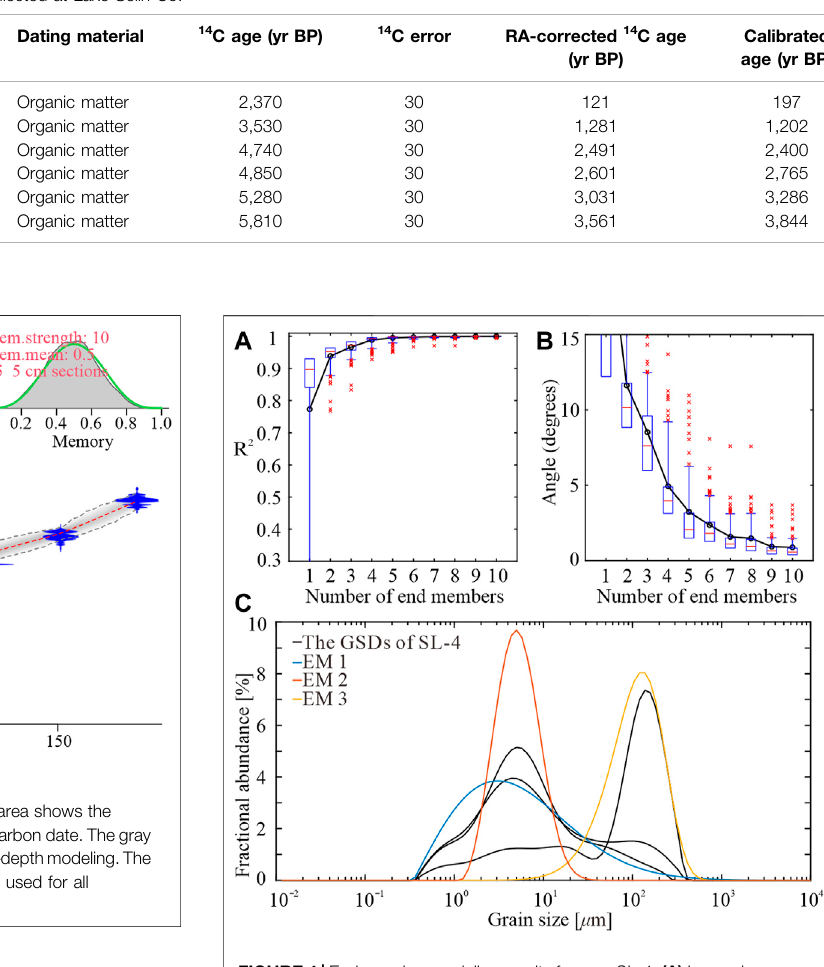
FIGURE 4 | End-member modeling results for core SL-4. (A) Increasing coef fi cient of determination ( R 2 ) as a function of the number of end-members (EMs) chosen to model the observed GSDs, from 1 to 10. (B) Angular differences (in degrees) between the reconstructed and observed data sets as a function of the number of end-members. (C) Plot of some observed GSDs (gray shading) overlain with the three retained EMs (colored lines) together. All EMs have a unimodal distribution, with varying width and